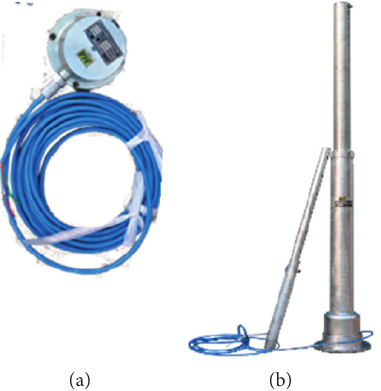
Figure 10: Monitoring instruments and implementation plans. (a) Filling body stress monitor. (b) Roof dynamic monitors.